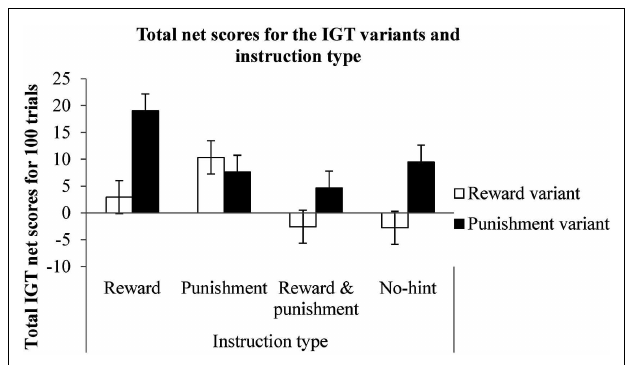
FIGURE 3 |Total net scores on the reward and the punishment variants (within-subjects) and the type of instructions (between subjects). Error bars represent standard